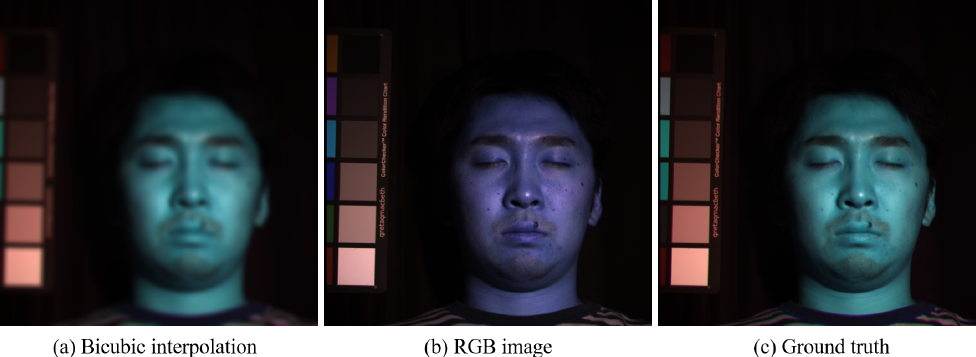
Figure 2. Face image from the CAVEdataset, where the color image consists of Spectral Bands 3, 25, and 30 for the red, green, and blue channels, respectively. ( a ) Bicubic interpolation of the observed low-spatial-resolution HSI, with a magnification factor of three; ( b ) RGB image after applying Nikon 700 spectral response; ( c ) the original high-spatial-resolution HSI considered as the ground truth.